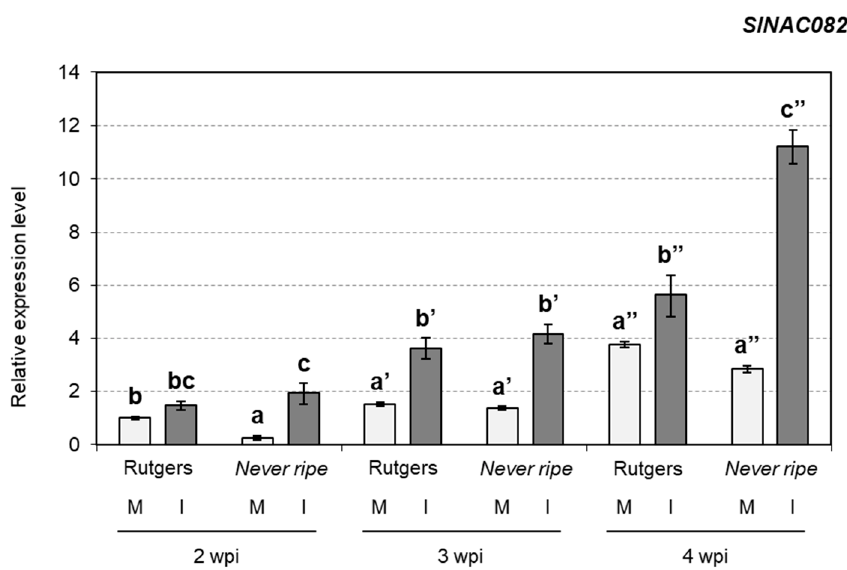
Figure 8. mRNA expression of SlNAC082 in Rutgers and Nr plants from mock (M) and CEVd infected (I) plants determined by qRT-PCR at two, three and four weeks post inoculation (wpi). Expression levels are relative to Rutgers mock plants and normalized to the tomato actin gene. Data correspond to the mean of at least two independent plants ± SD of at least three technical replicates. Results corresponding to one representative experiment are shown. Data were analyzed using a Mann–Whitney test and di ff erent letters indicate significant di ff erences ( p < 0.05). Number of ( ’ ) indicates di ff erent